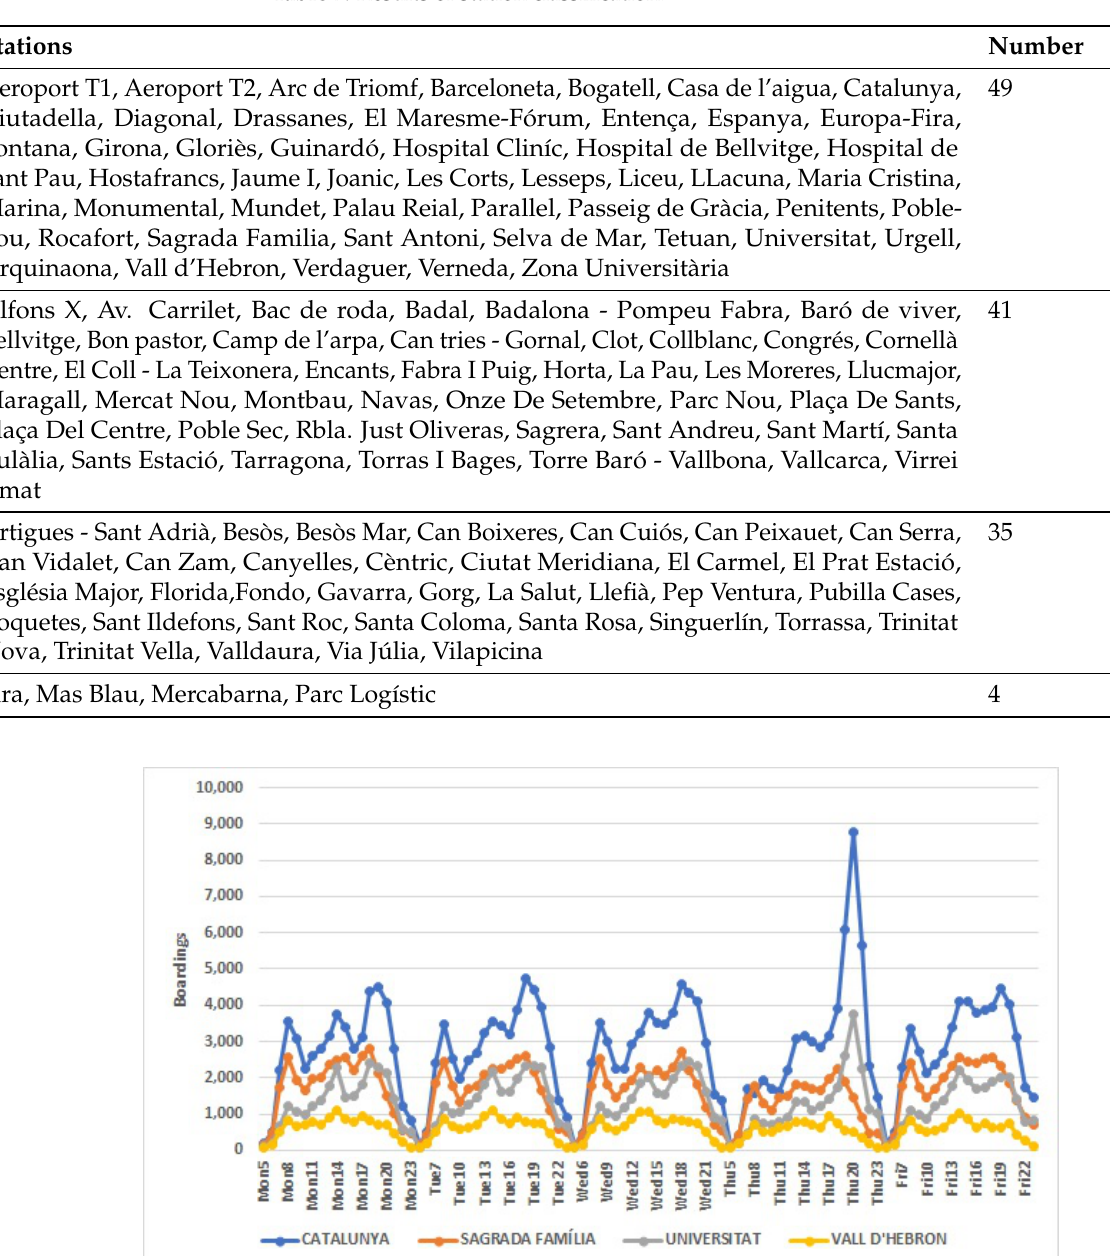
Table 7. Results of station classification.